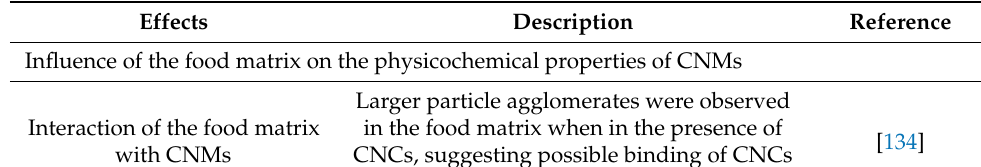
Table 1. Interactions of CNMs with food digestion, and possible effects on CNMs’ properties and food